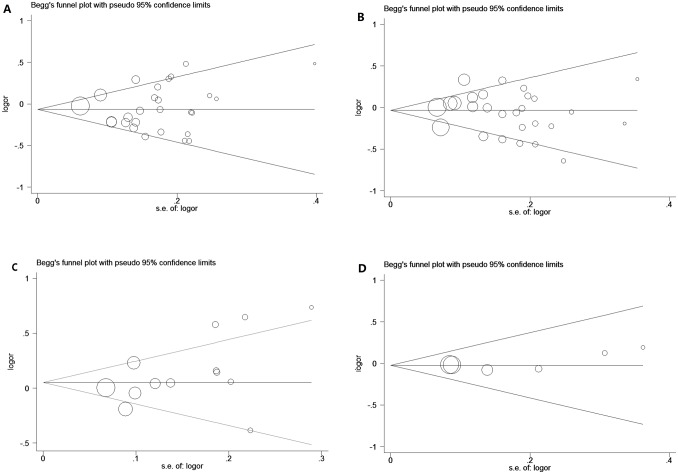
Begg's funnel plot for publication bias test.Each circle denotes an independent study for the indicated association. Log[OR], natural logarithm of OR. Horizontal line stands for mean effect size. A: rs11614913, B: rs2910164, C: rs37464444, D: rs2292832.